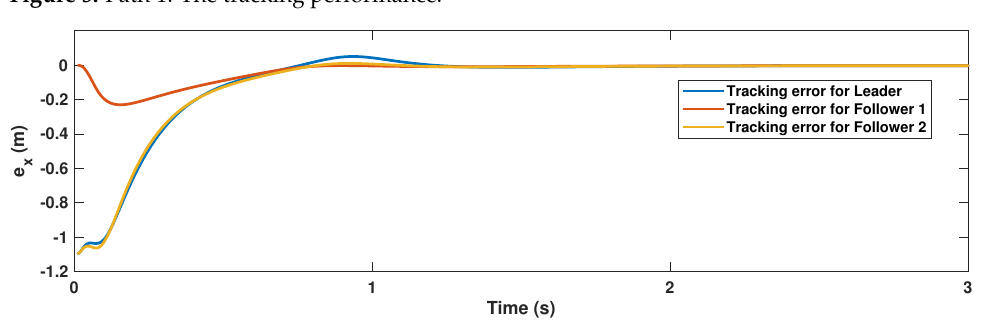
Figure 5. Path 1: The tracking performance.